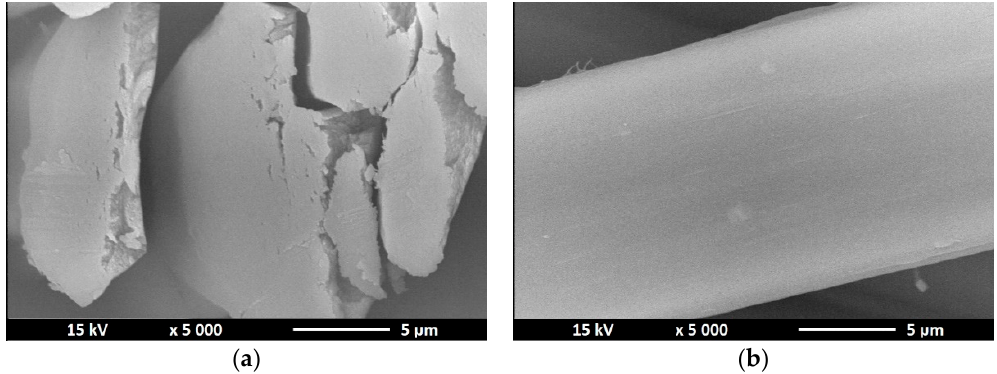
Figure 5. SEM images of cross section ( a ) and surface ( b ) of alginate fibers without nano additive.